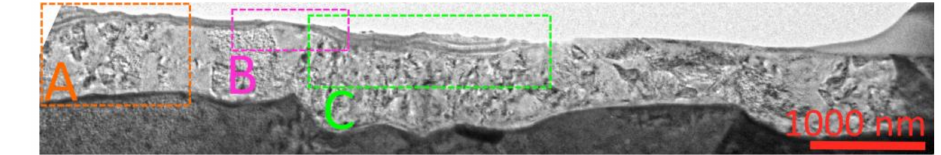
Figure 5. General view of the lamella and localization of Areas A, B, and C (after 16 min of cutting at f = 0.25 mm/rev, a p = 1.0 mm, and v c = 300 m/min) (TEM).